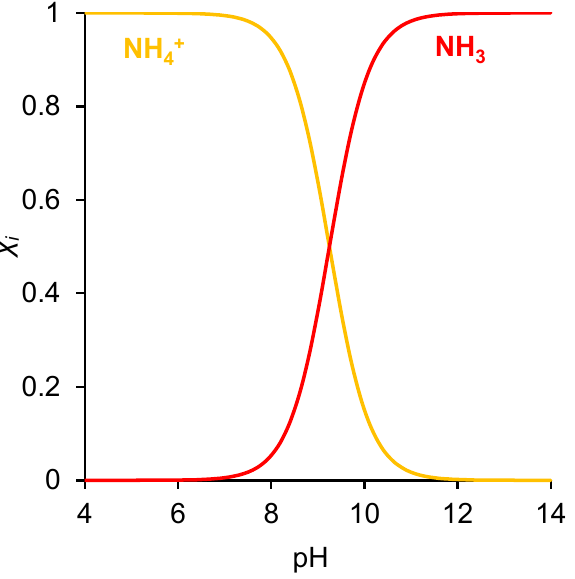
4+ and NH i ) of NH 3 as a function of